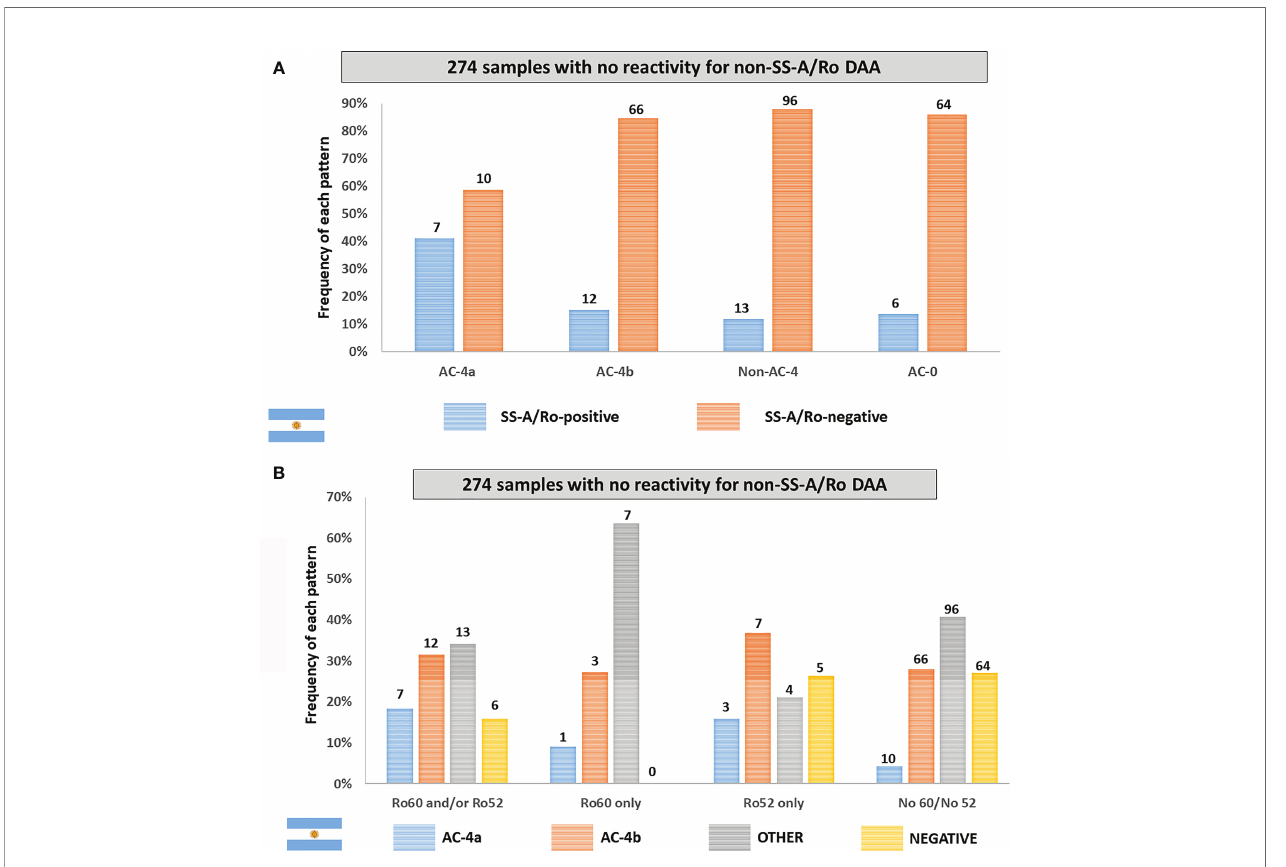
FIGURE 6 | Frequency of the AC-4a pattern and other patterns in samples with no disease-associated autoantibody (DAA) other than anti-SS-A/Ro according to data from the Immunology Laboratory of Durand Hospital in Buenos Aires, Argentina. This analysis included only samples that were negative for non-SS-A/Ro DAA: dsDNA, chromatin, histones, SmD1, U1-RNP, SS-B/La, Scl-70, CENP-B, Jo-1, and Ribosomal-P. (A) Samples were classi fi ed according to the presence or absence of antibodies to SS-A/Ro. The y -axis represents the percentage frequency for each pattern. (B) Samples were classi fi ed according to the fi ne speci fi city of anti-SS-A/Ro antibodies (anti-Ro60 and anti-Ro52). The y -axis represents the percentage frequency for each autoantibody combination. Absolute numbers in each category are shown at the top of